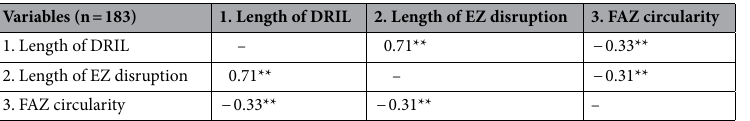
Table 4. Correlation between length of DRIL, length of EZ disruption, and FAZ circularity in diabetic eyes. DRIL, disorganization of retinal inner layer; EZ, ellipsoid zone; FAZ, foveal avascular zone. ** P <